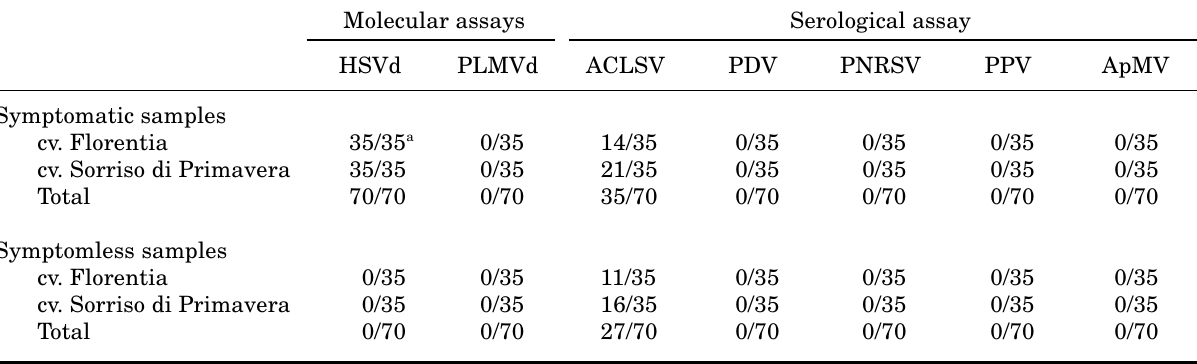
Table 1. Molecular (RT-PCR and dot-blot hybridization) and serological (ELISA) analysis of plum samples collected in Campania and Basilicata.